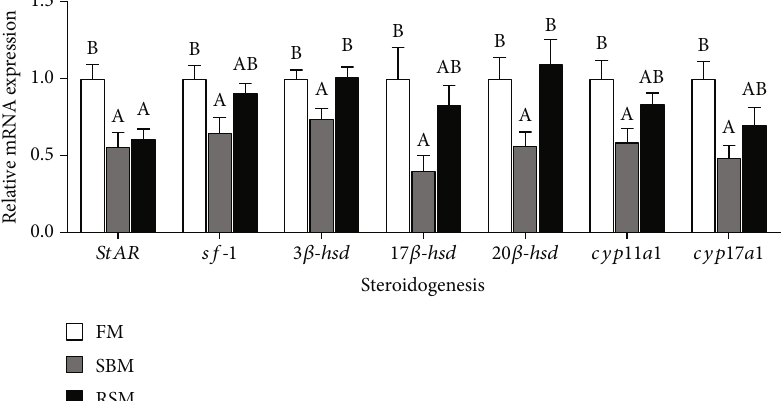
Figure 3: E ff ect of di ff erent dietary protein sources on gonadal mRNA expressions of steroidogenesis-related genes of female yellow cat fi sh broodstock. Values are expressed as means ± SE ; di ff erent letters represent the statistically signi fi cant di ff erences ( P < 0 : 05